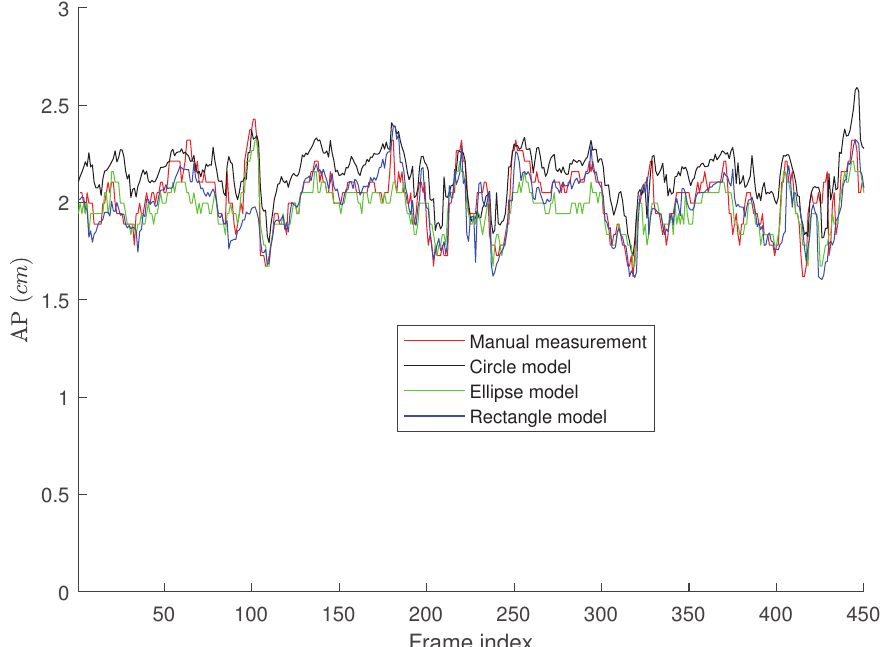
Figure 7. AP-diameter for the second video depicted in Figure 5, as measured by the manual measurement (red line), active circle algorithm (black line), active ellipse algorithm (green line) and active rectangle algorithm (blue line).